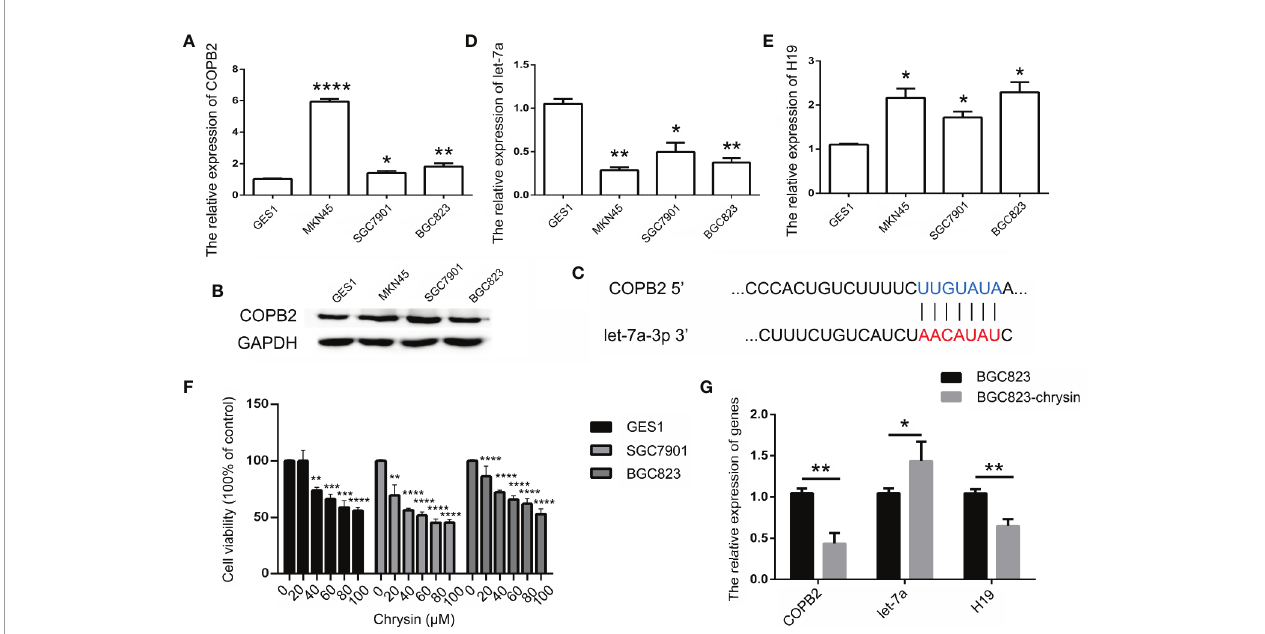
FIGURE 2 | Analysis of COPB2 , let-7a and H19 expression pattern. The expression of COPB2 in GC cells using qPCR (A) and western blot (B) . Schematic representations of COPB2 and let-7a (C) . Relative expression of let-7a in GC ells (D) . Relative expression of H19 in GC ells (E) . The cell growth was analyzed by CCK8 assay (F) . Relative expression of COPB2 , let-7a and H19 was analyzed by qPCR after chrysin treatment in GC cells (G) . The data are represented as the mean ± SD (n = 3). * ( p < 0.05), ** ( p < 0.01), *** ( p < 0.001) and **** ( p < 0.0001) indicate statistically signi fi cant